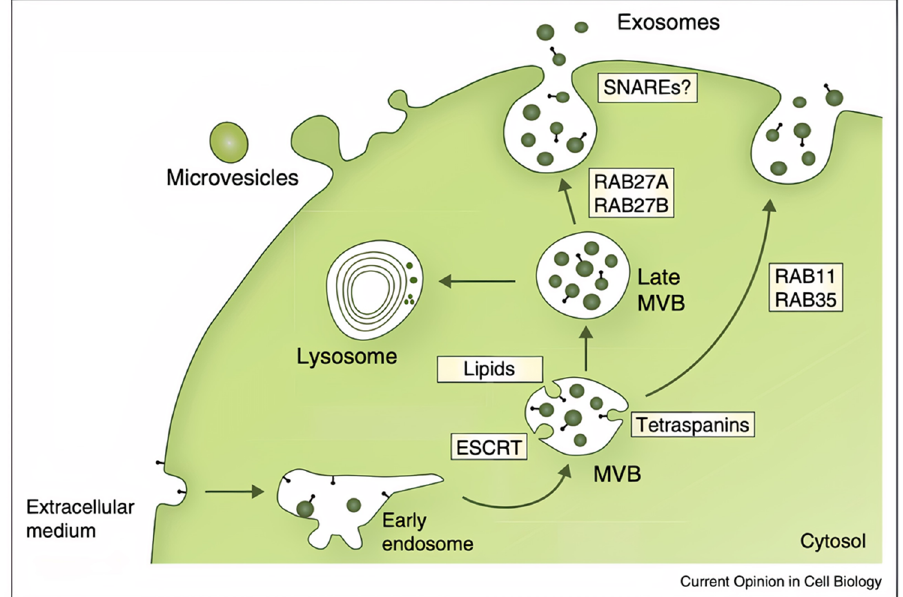
Figure 2. Exosome biogenesis and secretion [29]. Figure reproduced with permission from Else- vier.